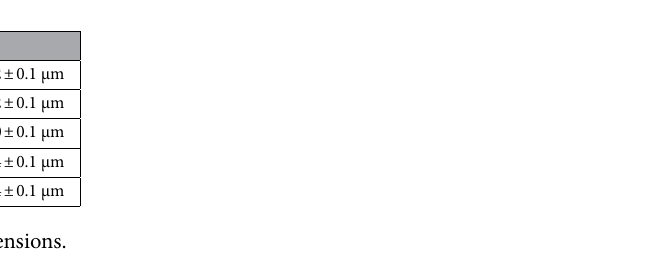
Figure 2. Ridge waveguides of ( a ) SU8 doped with RhB at 7 mM, ( b ) EpoCore doped with RhB at 5 mM, ( c ) SU8 doped with Py580 at 5 mM, ( d ) OrmoStamp doped with RhB at 7 mM, ( e ) OrmoStamp doped with C540A at 50 mM and ( f ) Structure of a ridge waveguide were w and h correspond to the width and height, respectively. The width of a-c waveguides is 15 µm whereas the OrmoStamp is 1100 µm.